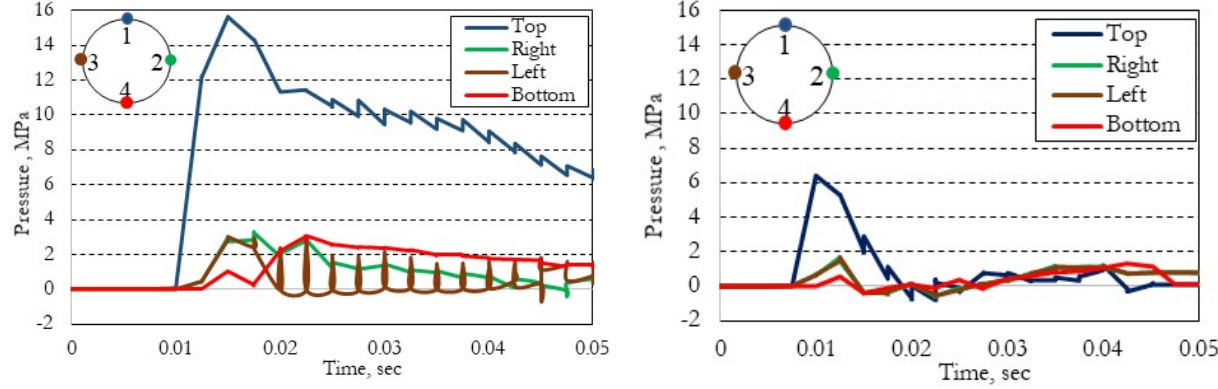
Figure 11: a. Pressure with time for soil (A). b. Pressure with time for soil